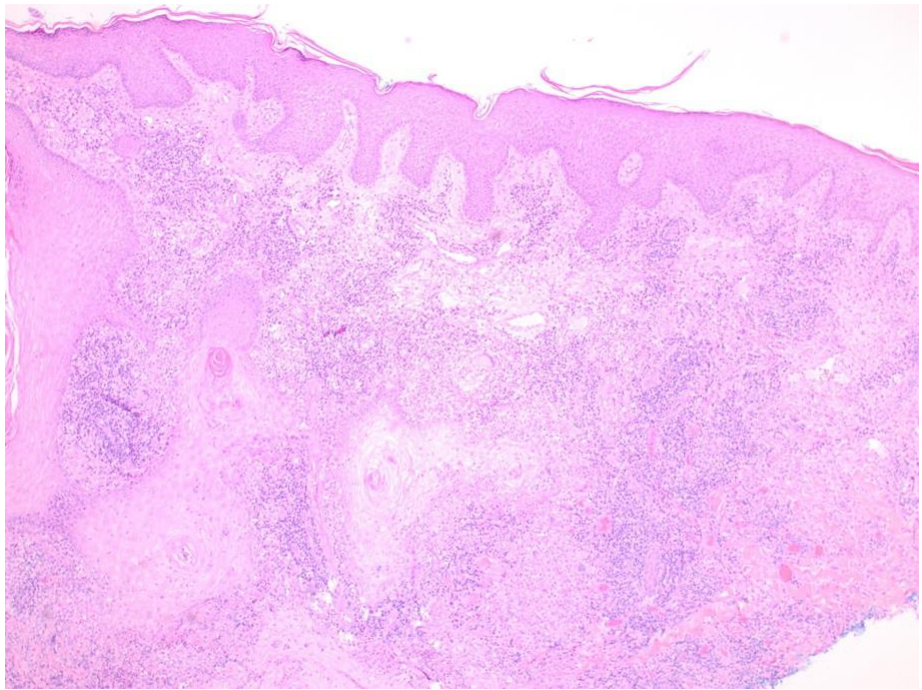
Figure 4. Photomicrograph of the biopsy specimen from the verrucous lesion on the right arm show- ing granulomatous dermatitis with pseudoepitheliomatous squamous proliferation, Hematoxylin and Eosin (H&E), 40×.